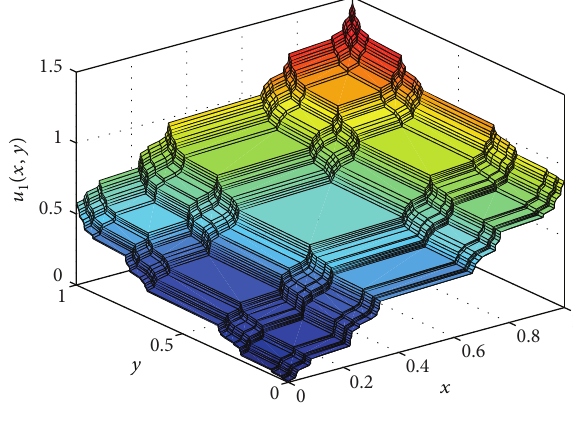
Figure 1: The plot of 𝑢 1 (𝑥,𝑦) with the parameter 𝛼 = ln 2/ ln 3 .